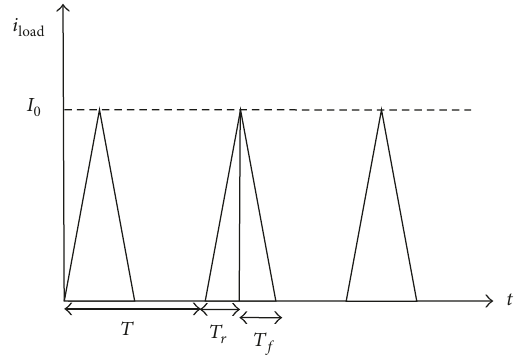
Figure 2: Switching current waveform.